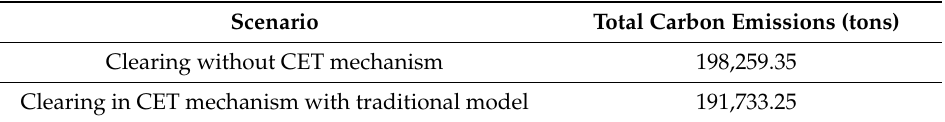
Table 2. Comparison of total system carbon emissions under di ff erent clearing